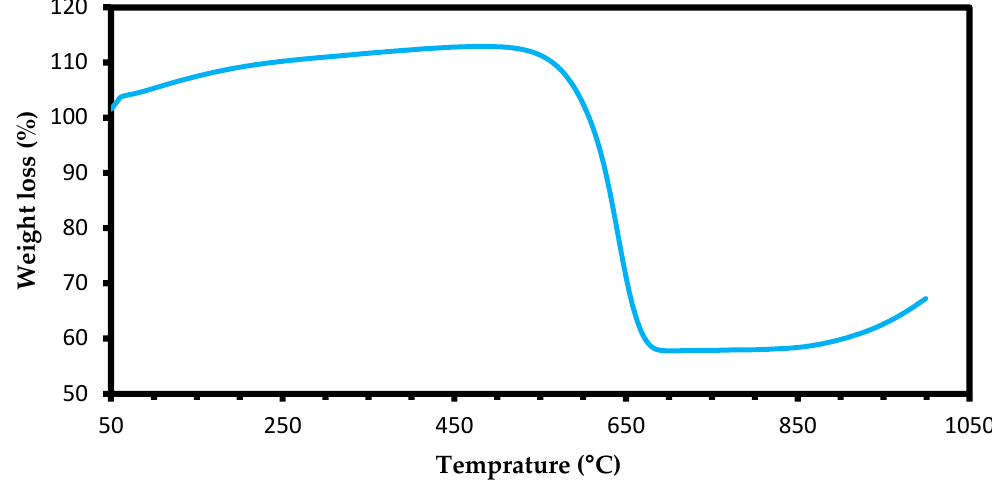
Figure 13. TGA profiles of the spent Pt,Pd,Ni / Mg 0.85 La 3 + 0.15 O catalyst (20 mL / min O 2 stream under a temperature ramp of 10 ◦ C /